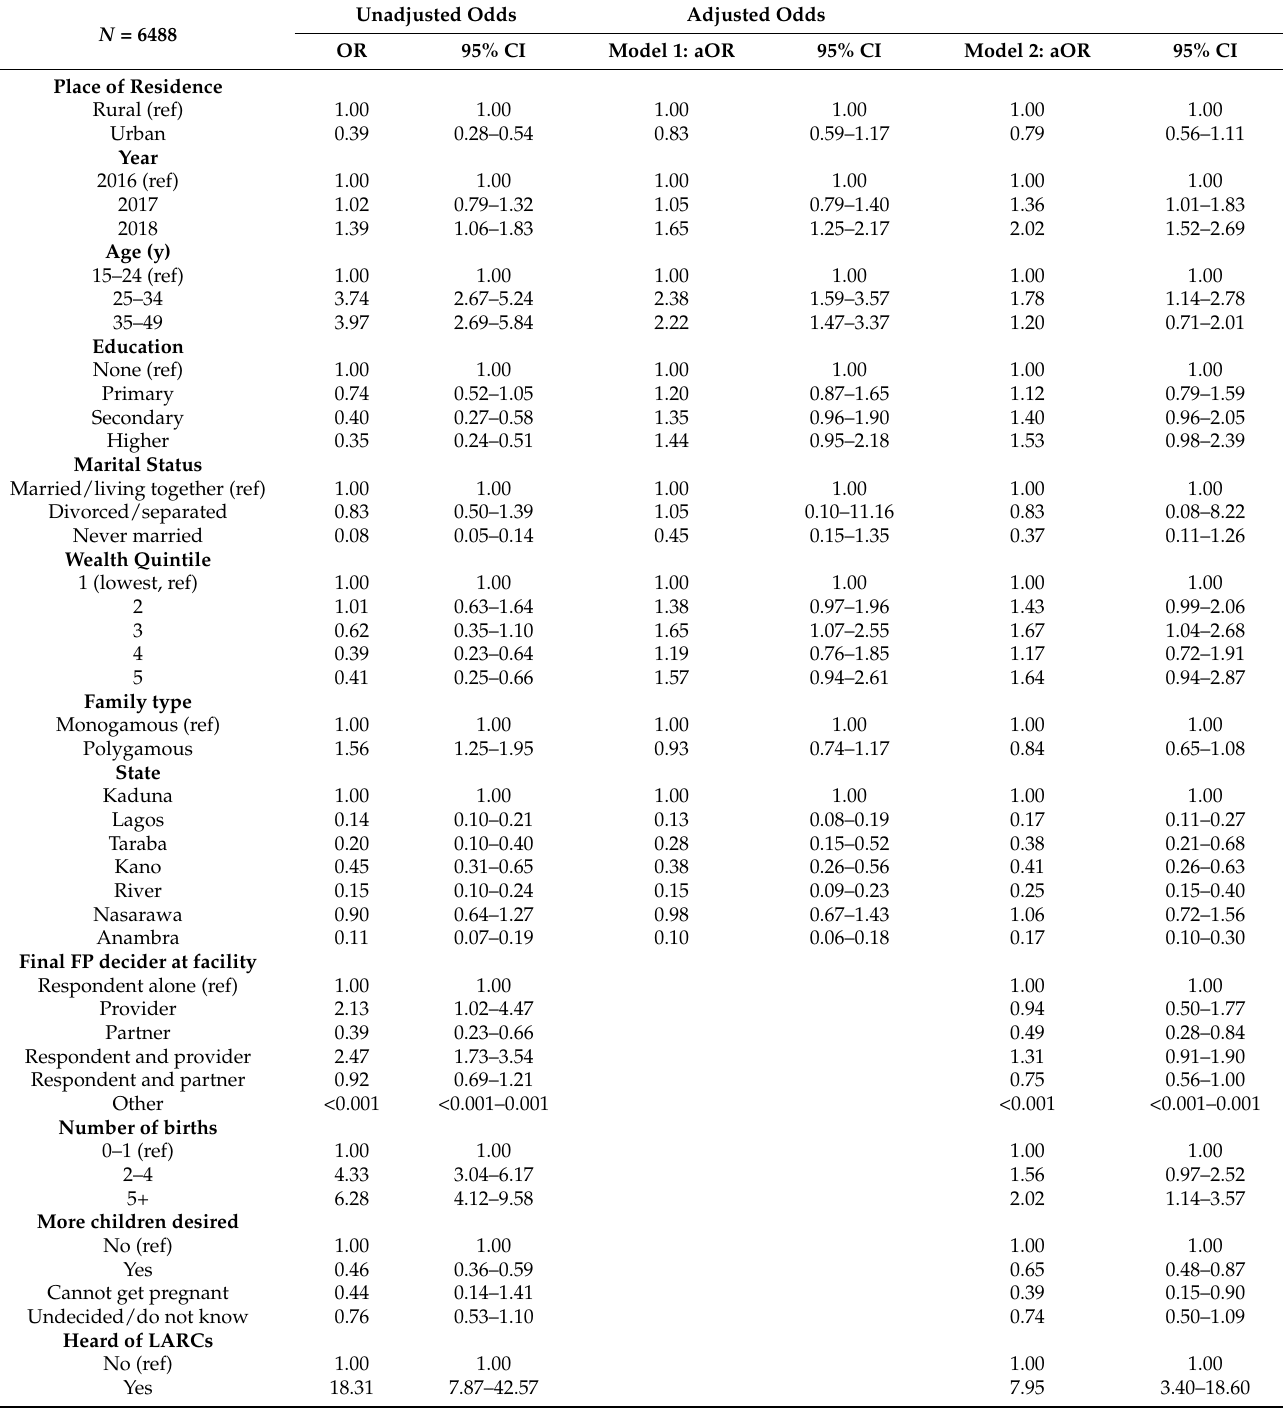
Table 5. Weighted crude and adjusted odds of implant use among Nigerian women aged 15–49 using